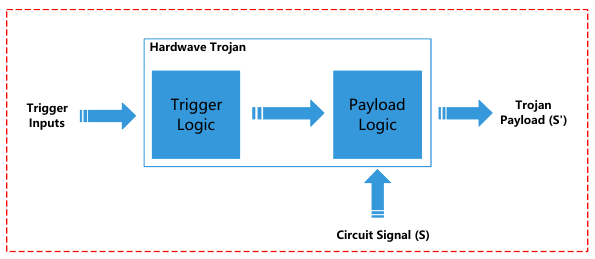
Figure 8. General structure of a HT in a